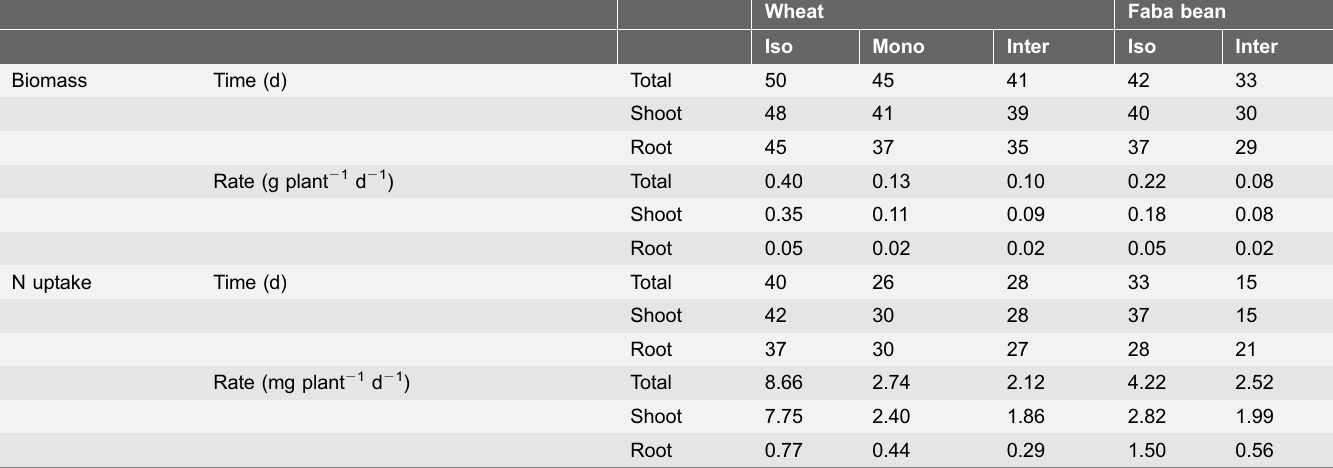
Table 2. Times and rates of maximum instantaneous biomass production and nitrogen uptake by wheat and faba bean estimated by a logistic model (Eqn 1).